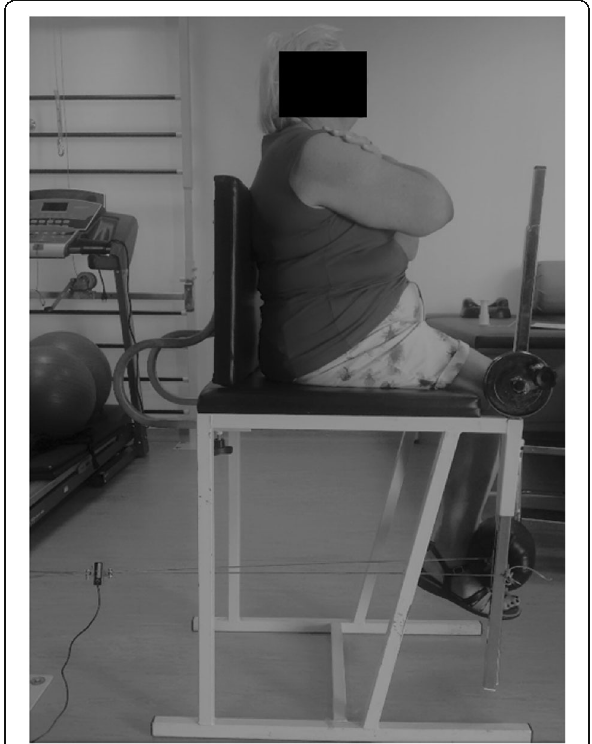
Fig. 2 Positioning of the volunteer for evaluation of muscle